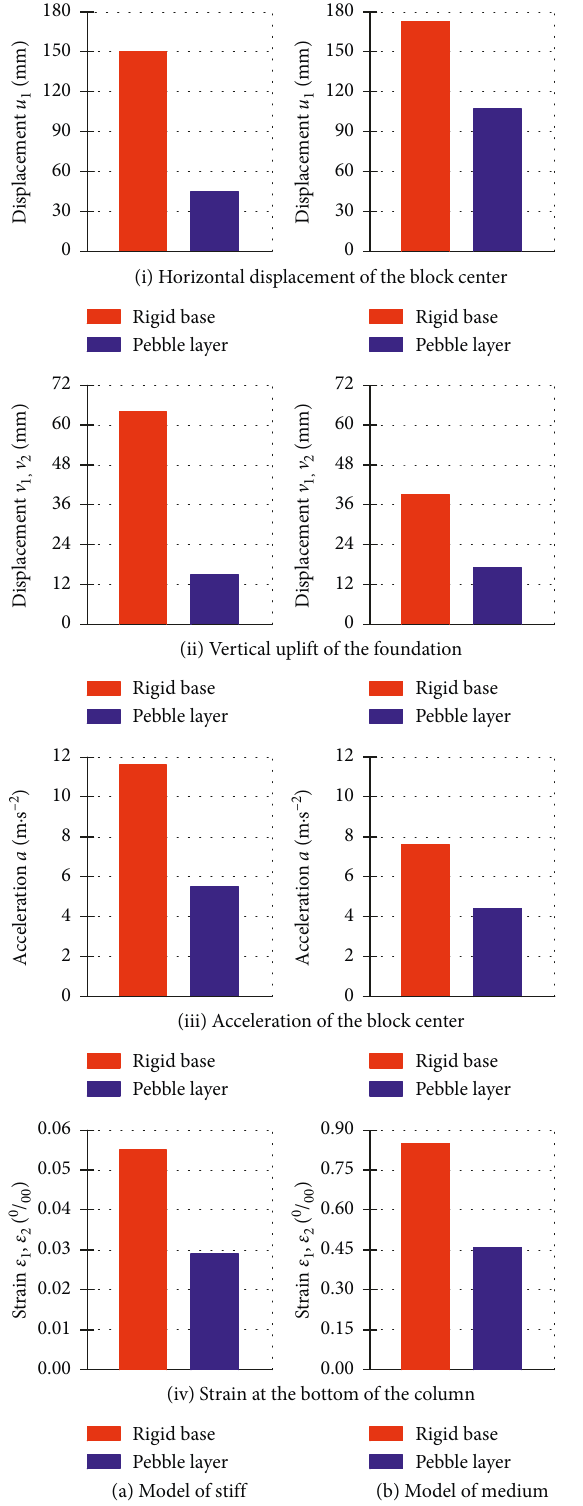
Figure 21: Some maximum measured values for the accelerogram Petrovac (AP). (a) Model of stiff building (MSB). (b) Model of medium stiff building